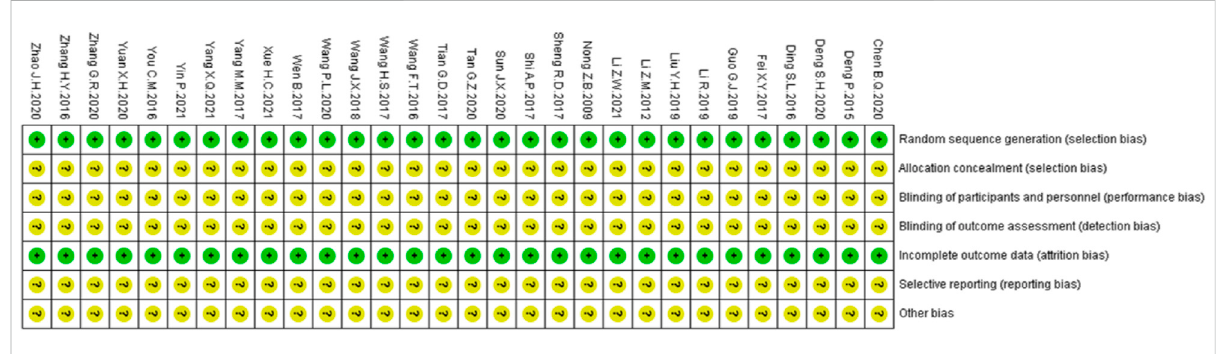
FIGURE 2 Results of the risk of bias assessment of the original literature included in the